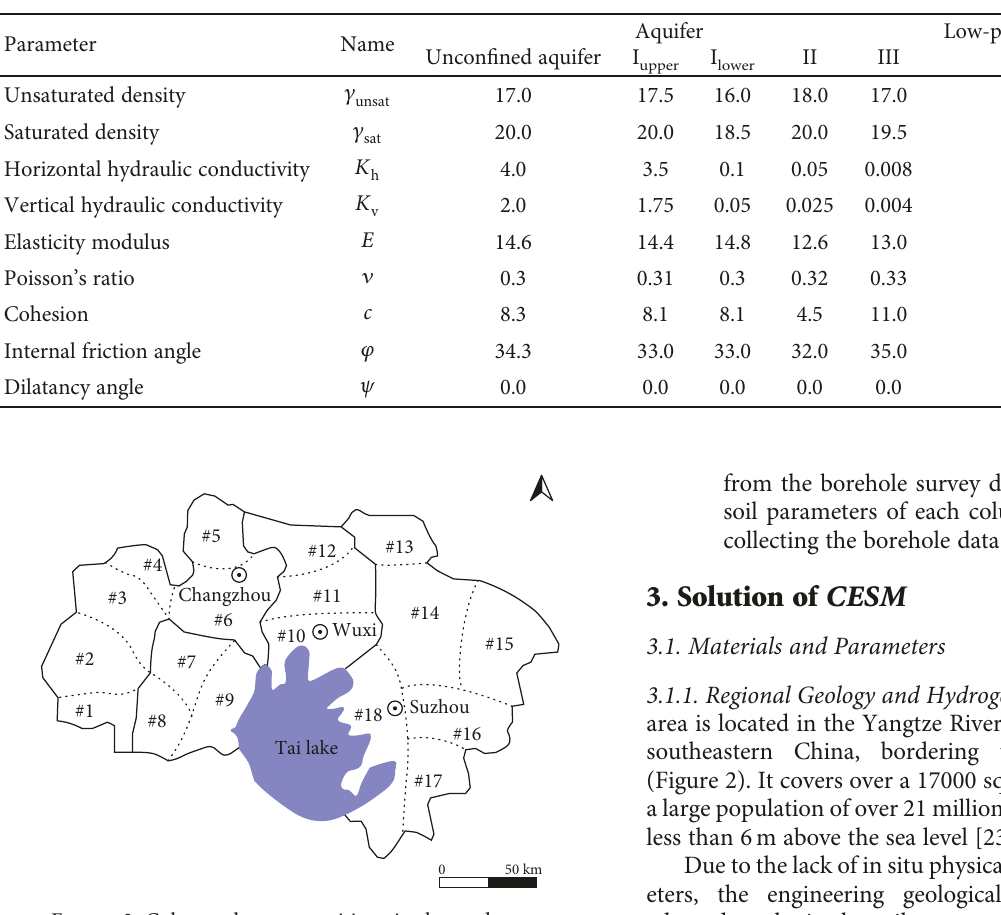
Table 1: Material parameters for di ff erent soil layers in the study